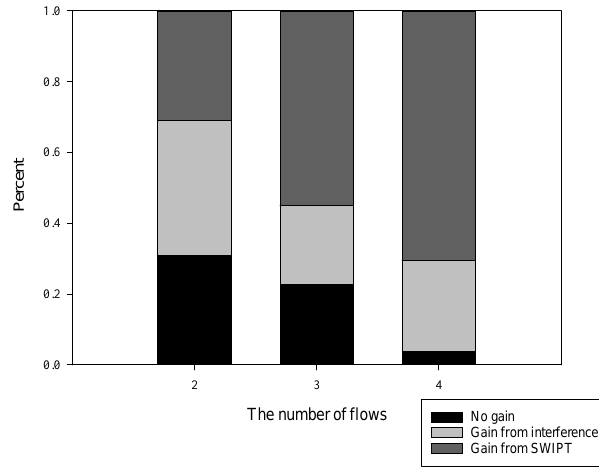
Figure 11. Categories distribution with the different number of